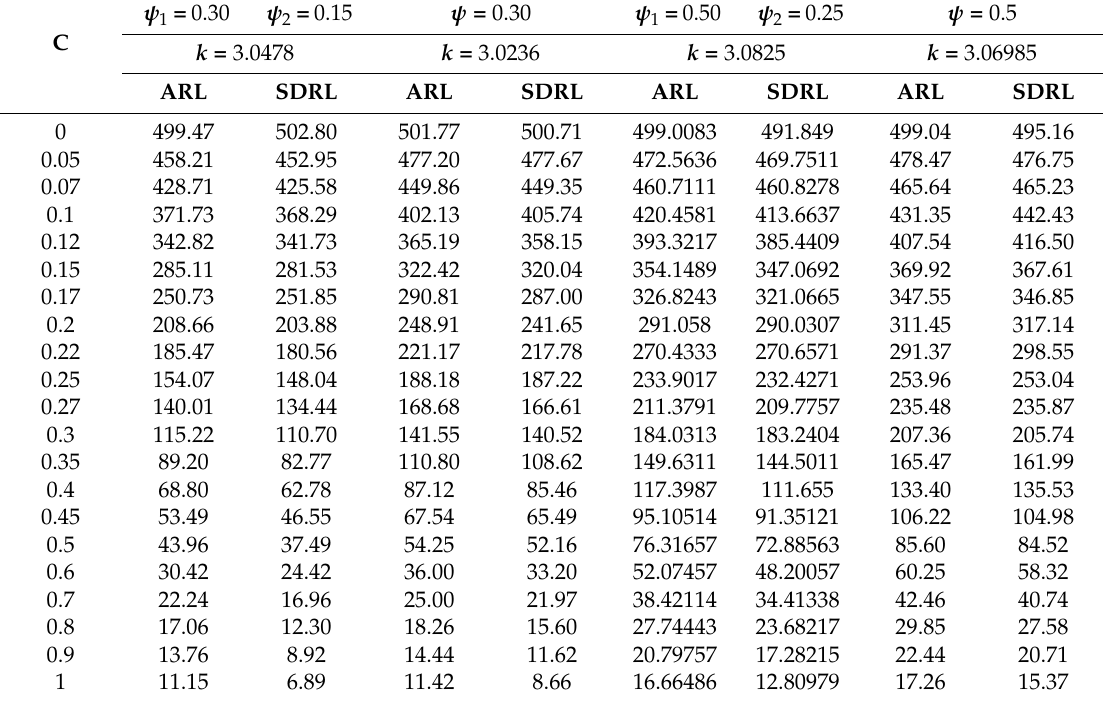
Table 2. The ARL, SDRL values of the proposed EEWMA and EWMA control charts for various shifts when r 0 = 500.